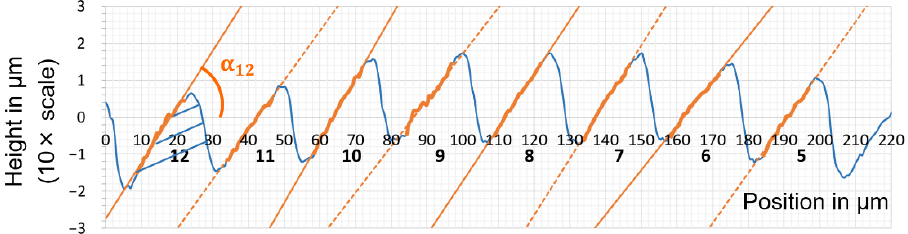
Figure 9. Mean height profile corresponding to Figure 8. The orange line estimated by linear regression and the x-axis were used for calculation of the eight tilting angles, respectively.